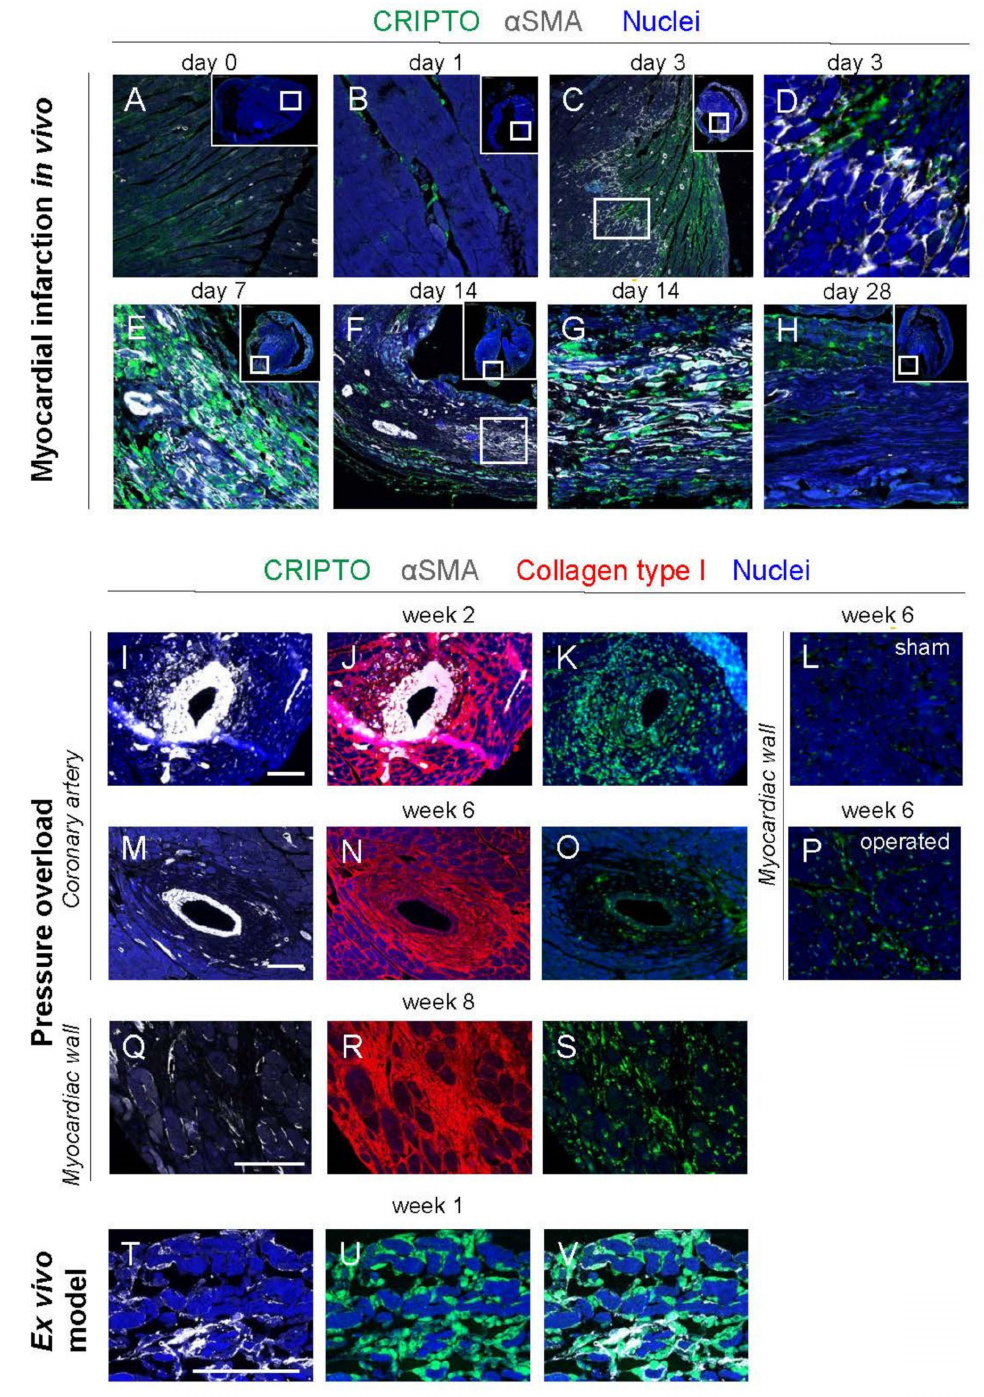
Figure 3. CRIPTO reactivation during wound-healing response to cardiac tissue injury.